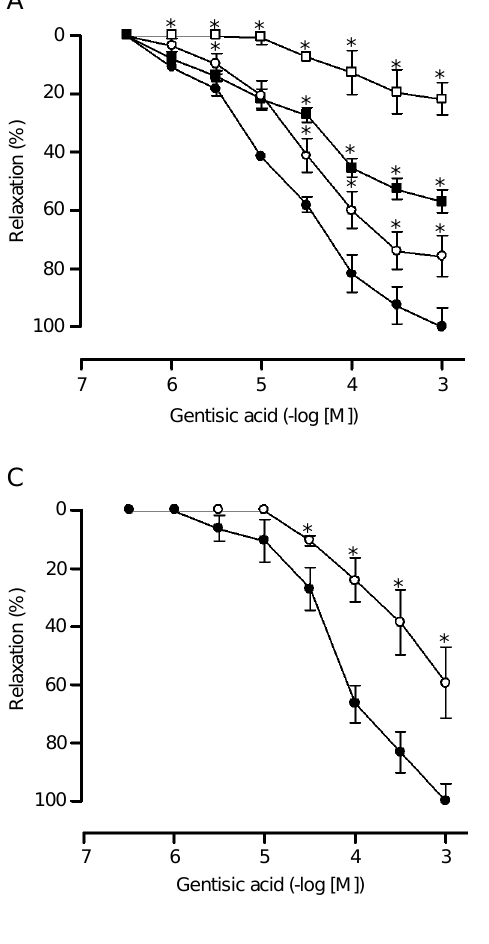
Figure 2 - Mean relaxant concen- tration-response curves for gen- tisic acid in the guinea pig tra- chea without epithelium in the absence (filled circles) or pres- ence of: A , KCl (open circles, 20 mM; filled squares, 40 mM, or open squares, 80 mM); B , tetra- ethylammonium (open squares, 100 µM); C , 4-aminopyridine (open circles, 10 µM). Data are reported as means ± SEM of 6 experiments. *P<0.05 for the difference between points (Stu- dent t